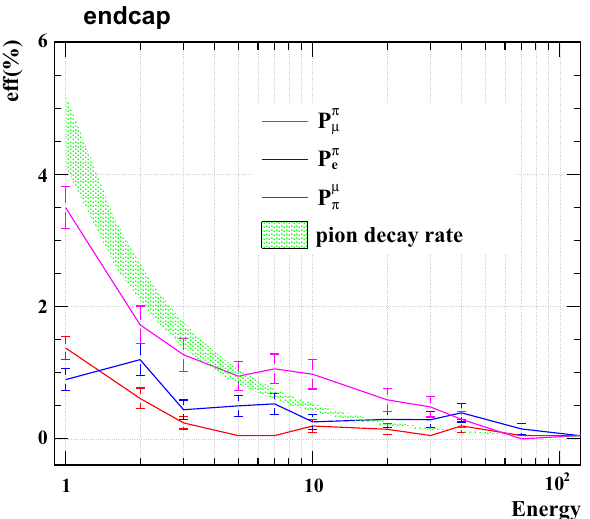
Fig. 6 The mis-identification rates of lepton identification for μ and π in ∼ 5000 events for the endcap region; Pion decay rate band (to account for the polar angle spread ) is indicated for comparison